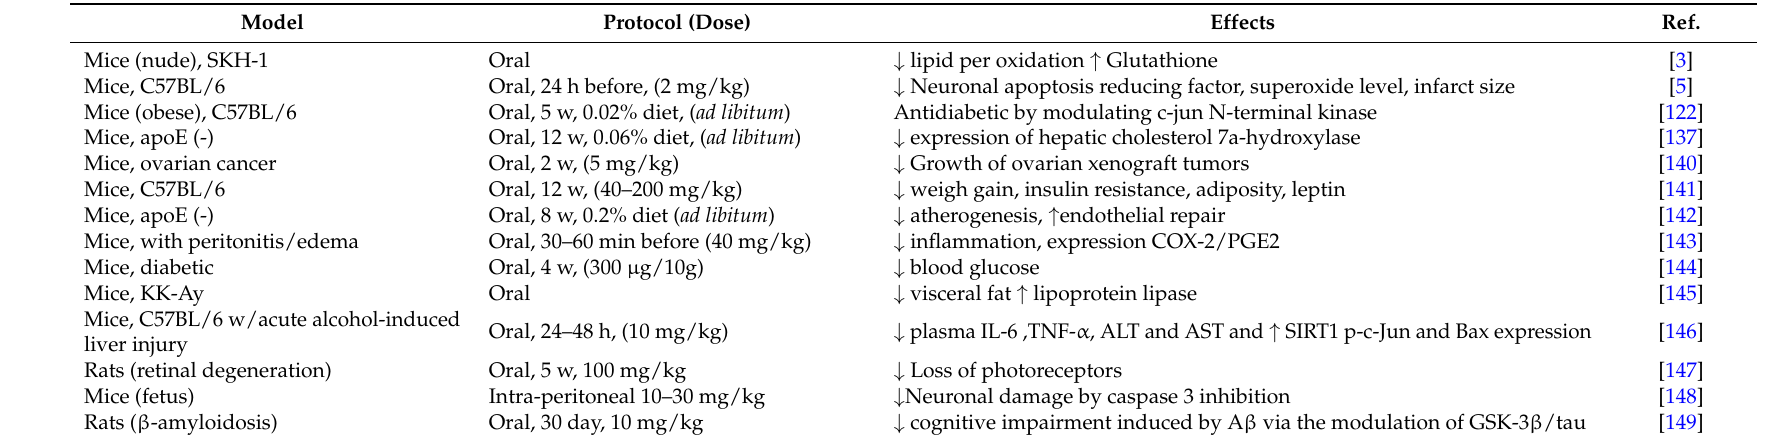
Table 5. Cy3G associated effects-rodent